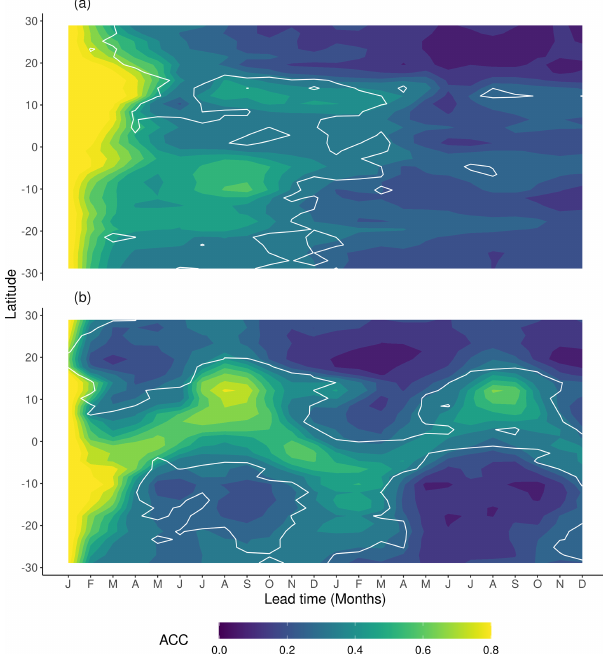
Figure 2. Zonal means of ACC derived from 35 ensemble simu- lations starting in January for (a) NPP and (b) Rh. Contour lines indicate correlations above the 95% confidence level.